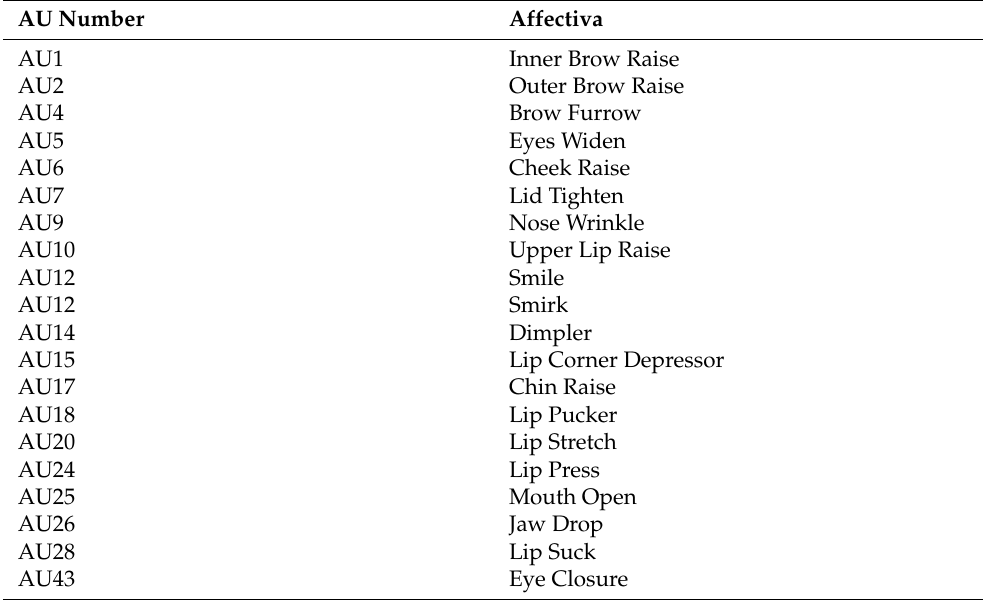
Table 1. Action Units recognized by